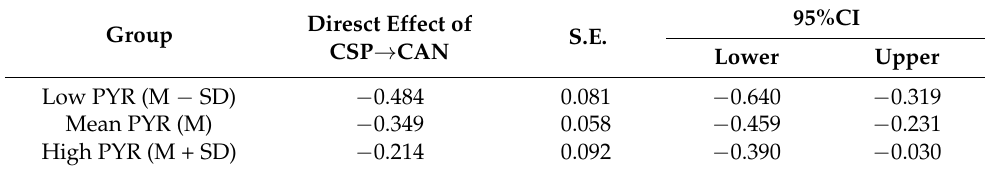
Table 8. Regulating effect of high and low groupings.